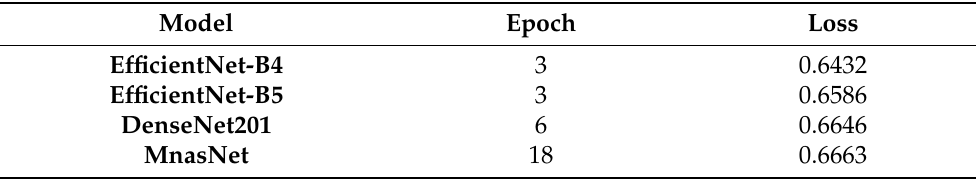
Table 5. The early-stopped validation loss for each